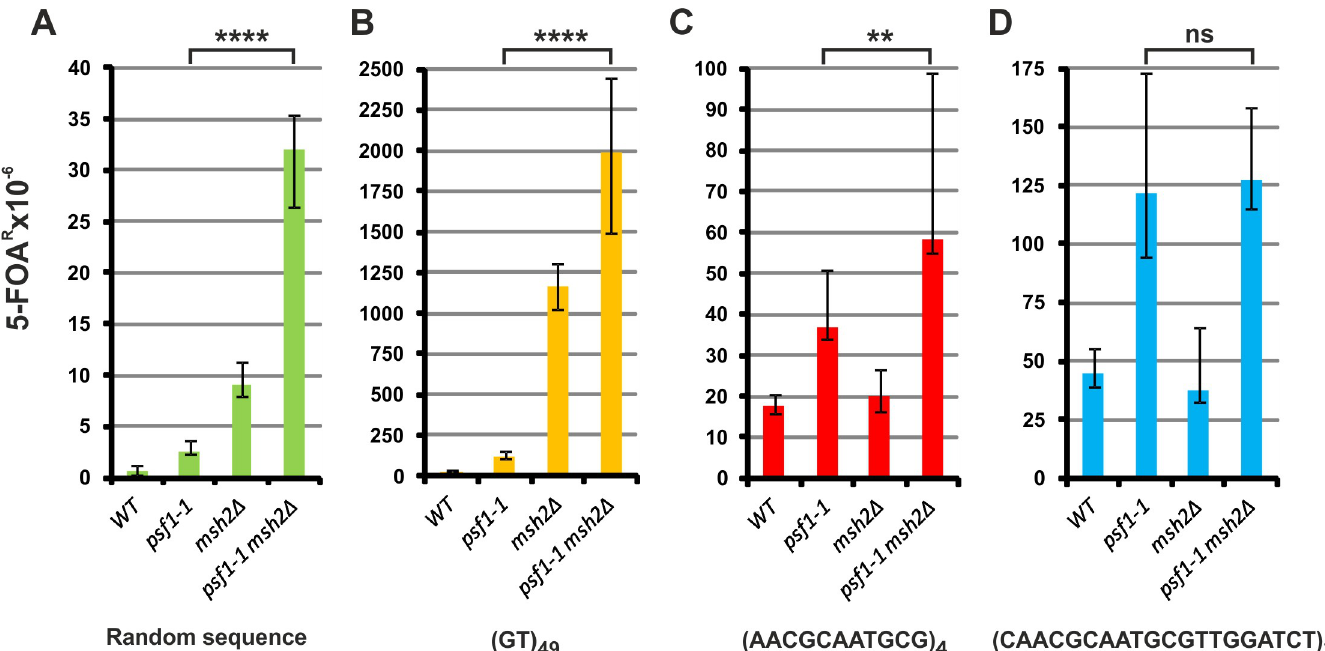
Fig 3. Effect of mismatch repair on repeat tract stability in psf1-1 cells (A-D). The 5-FOA R mutation rates were determined at 23˚C for yeast cells with the indicated genotypes carrying plasmids with the analyzed sequences; the values are medians with 95% confidence intervals calculated from data for at least ten cultures of each strain; the p -values for psf1-1 msh2 Δ versus psf1-1 mutant strains were calculated using the nonparametric Mann-Whitney U statistical test ( ���� p � 0.0001; �� p � 0.01; ns– p > 0.5). All associated p -values are presented in the S1 Table.